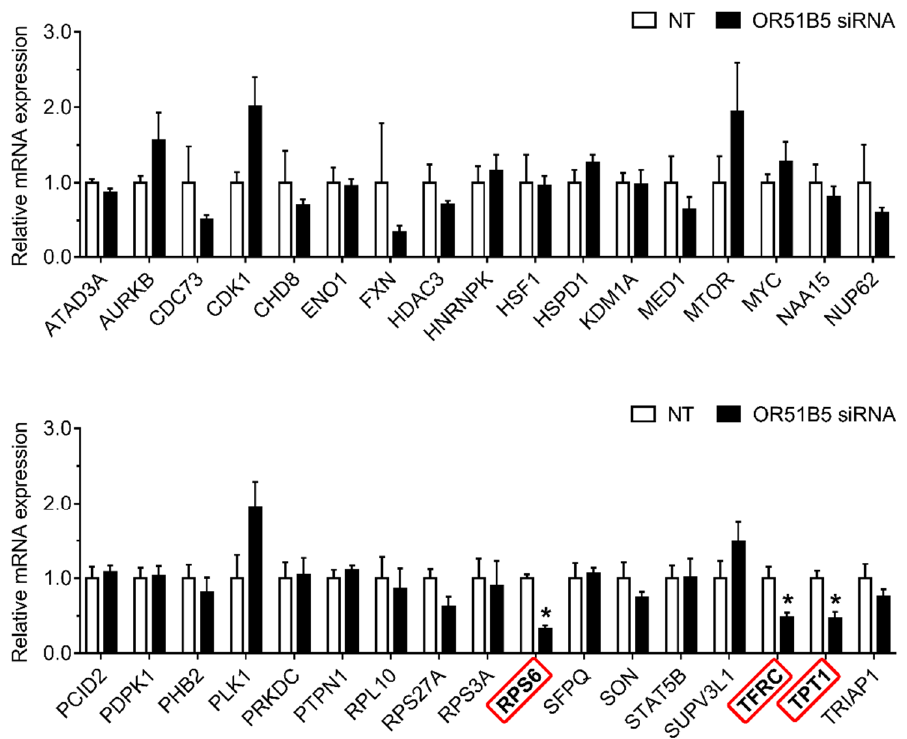
Figure 7. OR51B5 knockdown decreased cell survival-related gene expression in Hs68 cells. The cells were transfected with siRNA targeting OR51B5 or non-targeting siRNA (NT) and were further cultured for 72 h. The relative mRNA levels of cell survival-related genes were measured by quantitative PCR. Gene abbreviations are defined in supplementary Table S1. The results are expressed as mean ± SEM of three independent experiments. * p < 0.05.